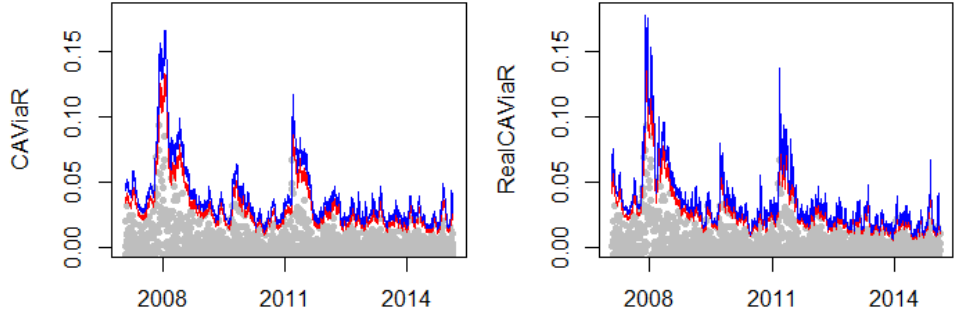
Figure 5. Predicted VaR ( red ) and ES ( blue ) at the α = 0.01 level for the CAViaR and Realized CAViaR models, and losses of the validation sample ( grey ). Table 2. p -values of the UC, IND and CC tests of Christoffersen (1998) on the VaR predictions, and of the bootstrap test (BOOT) on the ES predictions. Rejections at the 5% level are in bold.